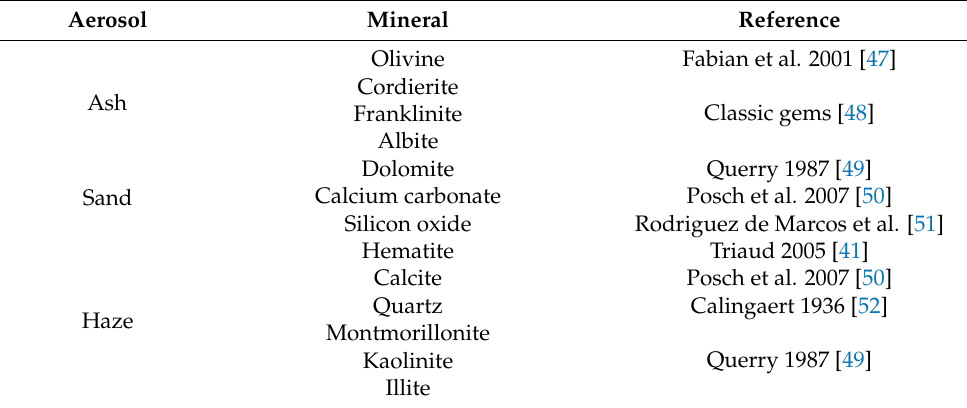
Table 3. Source for the mineral’s dielectric